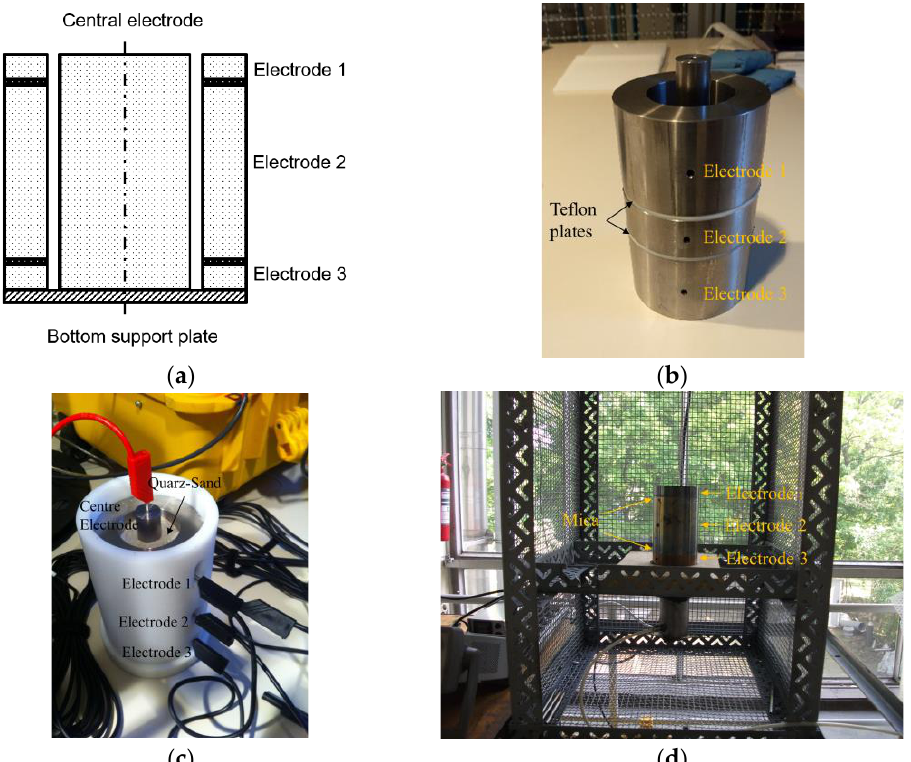
Figure 2. Schematic and pictorial description of the test cell used for measuring the surface and volumetric electrical properties of the DBD reactor bed materials at room and high temperature. ( a ) Schematic; ( b ) electrode with Teflon insulation; ( c ) test cell filled in with samples used at room temperature; ( d ) test cell used at a higher temperature.